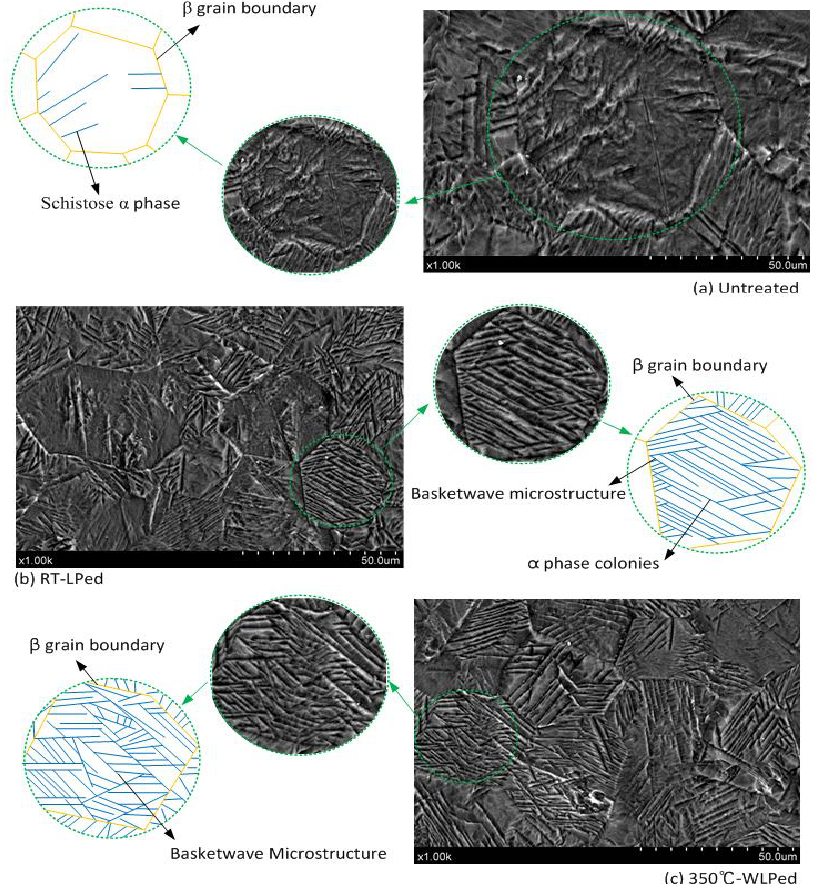
Figure 5. Microstructure in the surface of ( a ) Untreated, ( b ) RT-LSPed and ( c ) 350 °C-WLSPed